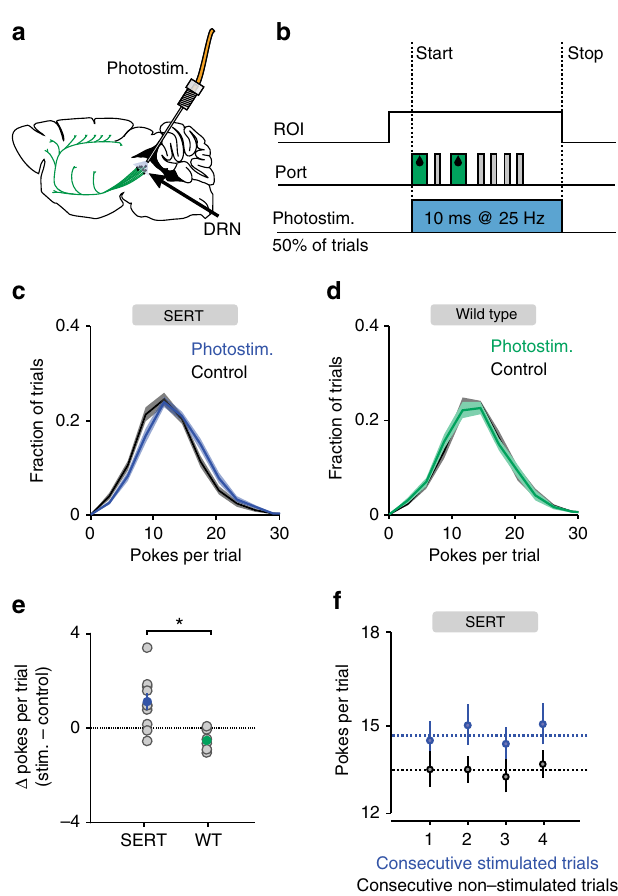
Fig. 3 The effect of DRN 5-HT photostimulation on switching behavior. a Scheme of the locations of ChR2-YFP expression and optic fi ber placement (adapted with permission from ref. 63 ). b Schematic diagram of task events during a single trail, also showing the period of photostimulation. Photostimulation was triggered by the fi rst poke in 50% of correct trials and ended either when the mouse left the ROI or if 10 s had elapsed since the last poke. c Distributions of the number of pokes per trial for photostimulated trials (blue) and control trials (black) averaged across the population of SERT-Cre mice ( n = 10). d Distributions of the number of pokes per trial for photostimulated (green) and control (black) trials, across the population of wild-type mice ( n = 6). e Difference between average number of pokes in photostimulated and control trials for SERT-Cre ( n = 10) and wild-type ( n = 6) mice. Averages across mice are shown in fi lled circles. * p < 0.05, Wilcoxon rank-sum test. f Plot showing the average number of pokes in photostimulated and control trials for SERT-Cre mice ( n = 10) as a function of consecutive numbers of photostimulated (blue) or control (black) trials. There was no effect of sequence length on behavior, p > 0.05, linear regression